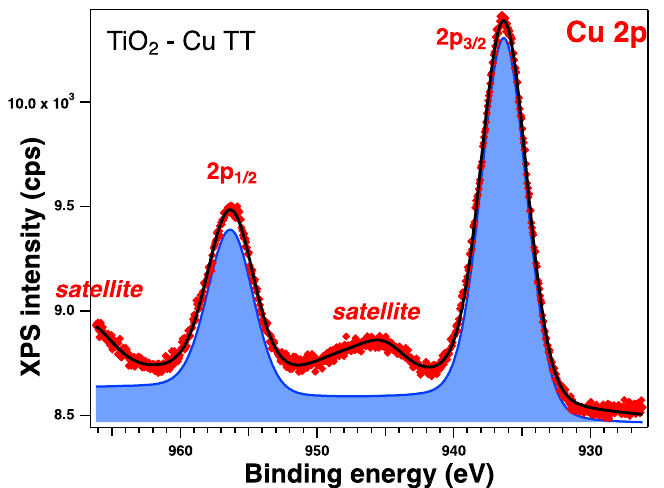
Figure 12. XPS spectra of Cu 2p level of the thermally treated Cu-doped sample: red symbols for the experimental data and black line for the fit with one component (blue line) and satellite peaks.